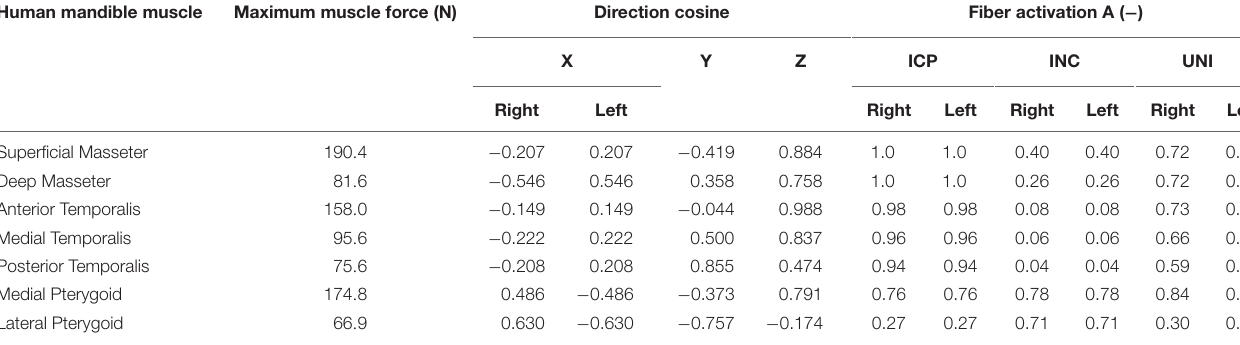
TABLE 2 | Muscle groups’ maximum force, direction cosines, and activation patterns, based on the specific clenching tasks in the human mandible. Human mandible